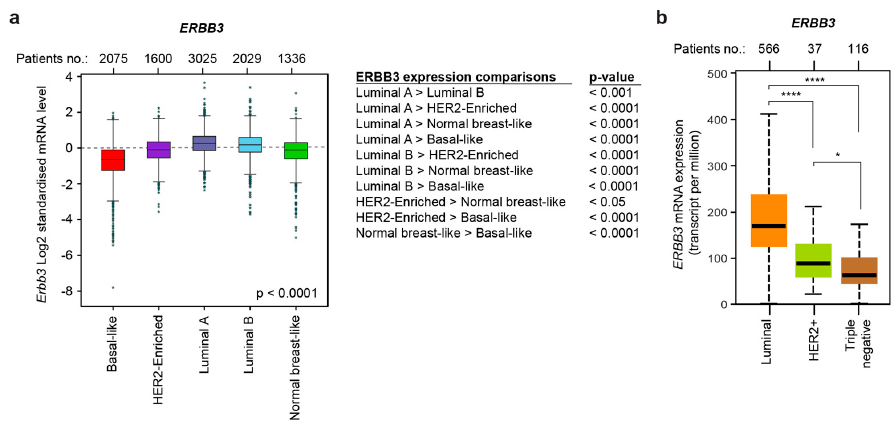
Figure 2. Basal-like/triple-negative breast cancers express low ERBB3 mRNA levels compared to other breast cancer subtypes. ( a ) Box plot of ERBB3 gene expression in breast cancer patients stratified for molecular subtypes (PAM50, n = 10,065 patients); ( b ) box plot of ERBB3 gene expression in breast cancer patients stratified for clinical subtypes (n = 719 patients); p -values are provided; * p < 0.05 and **** p < 0.0001.